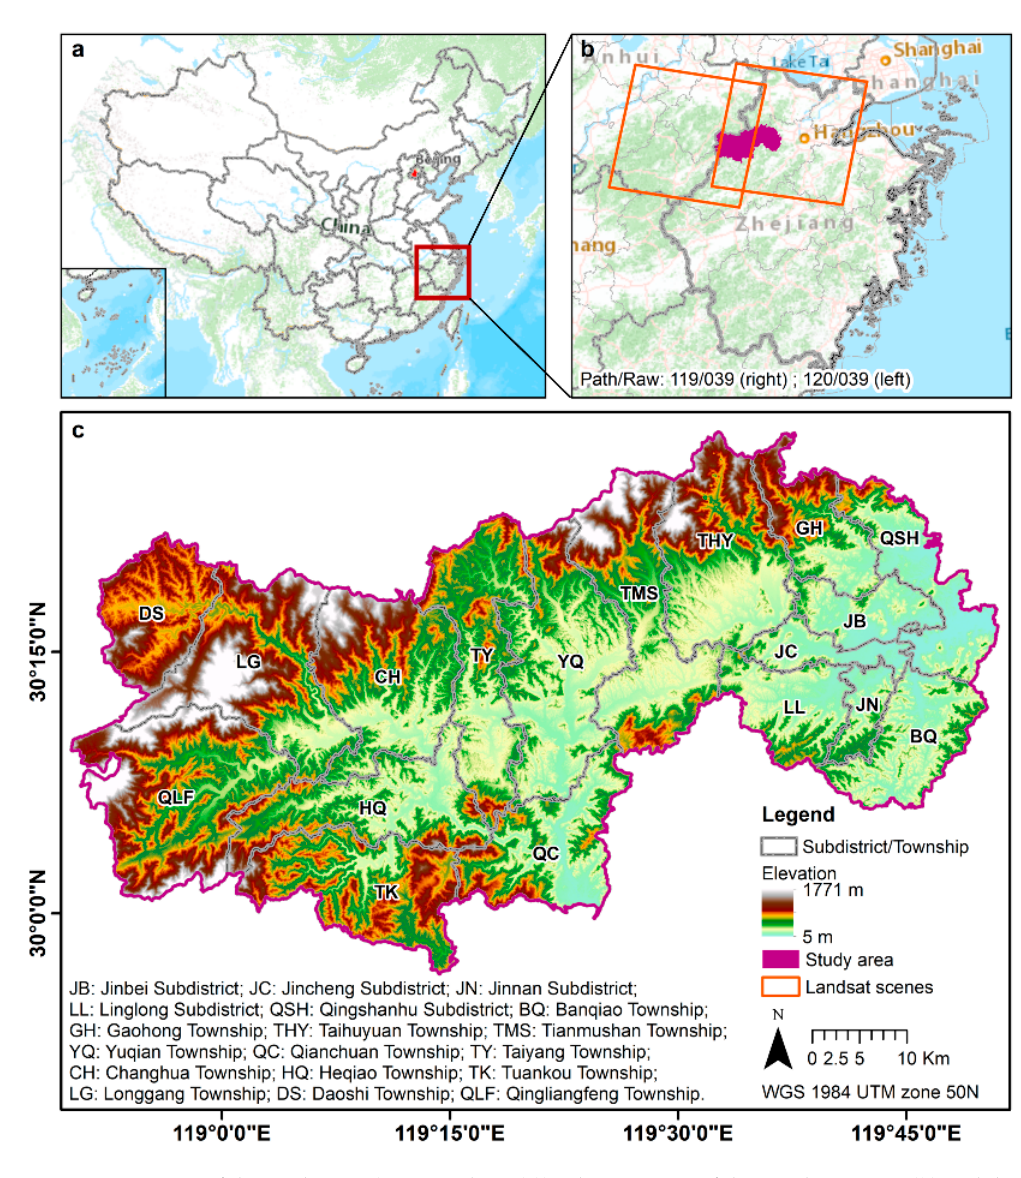
Figure 1. Location of the study area (Lin’an, China ( a )). The coverage of the Landsat scenes ( b ) and the spatial distribution of the subdistricts/townships ( c ).